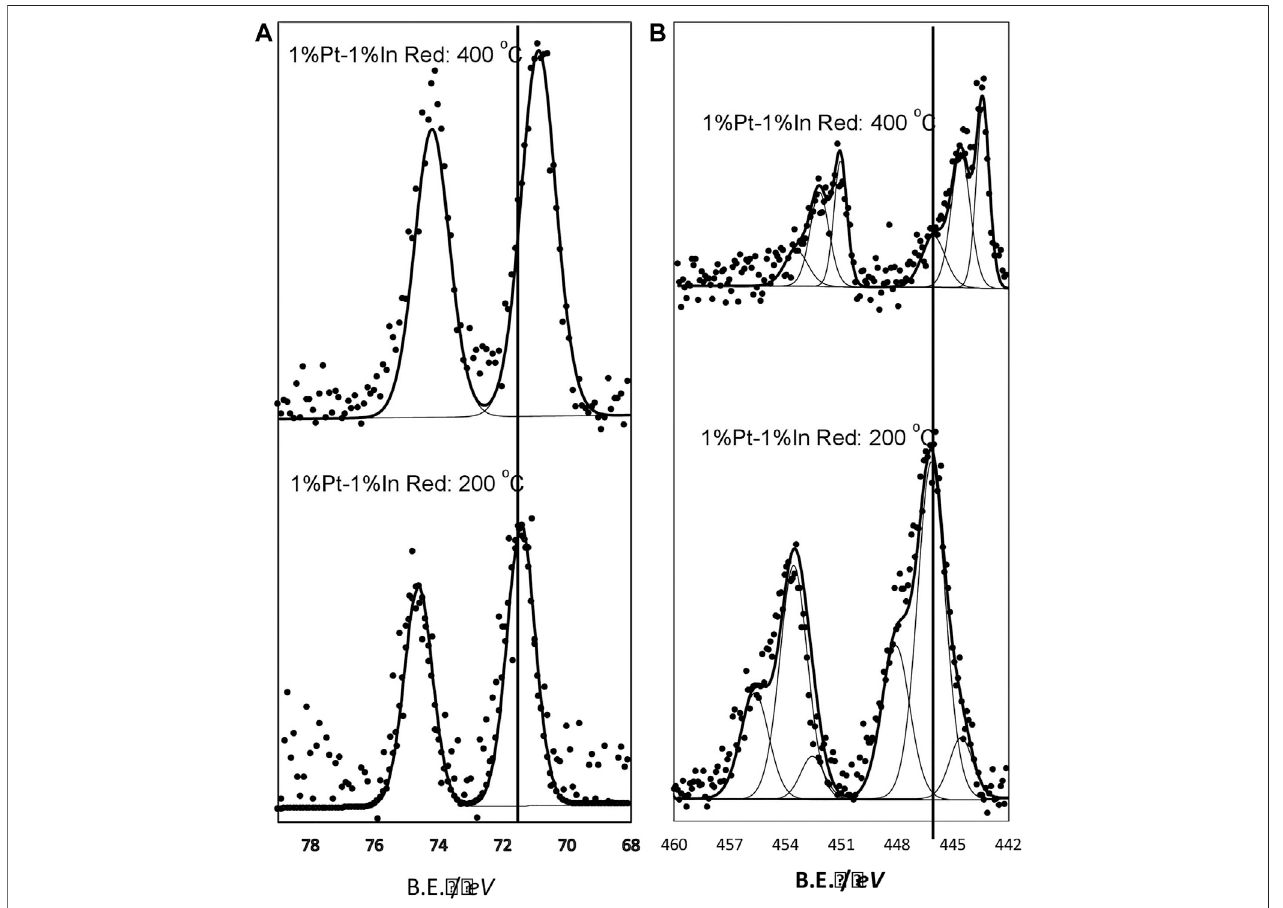
FIGURE 7 | In 3 d core level spectra (A) Pt 4 f core level spectra (B) . Samples treated at 400 ° C in N 2 and further reduced in hydrogen at 200 and 400 ° C.